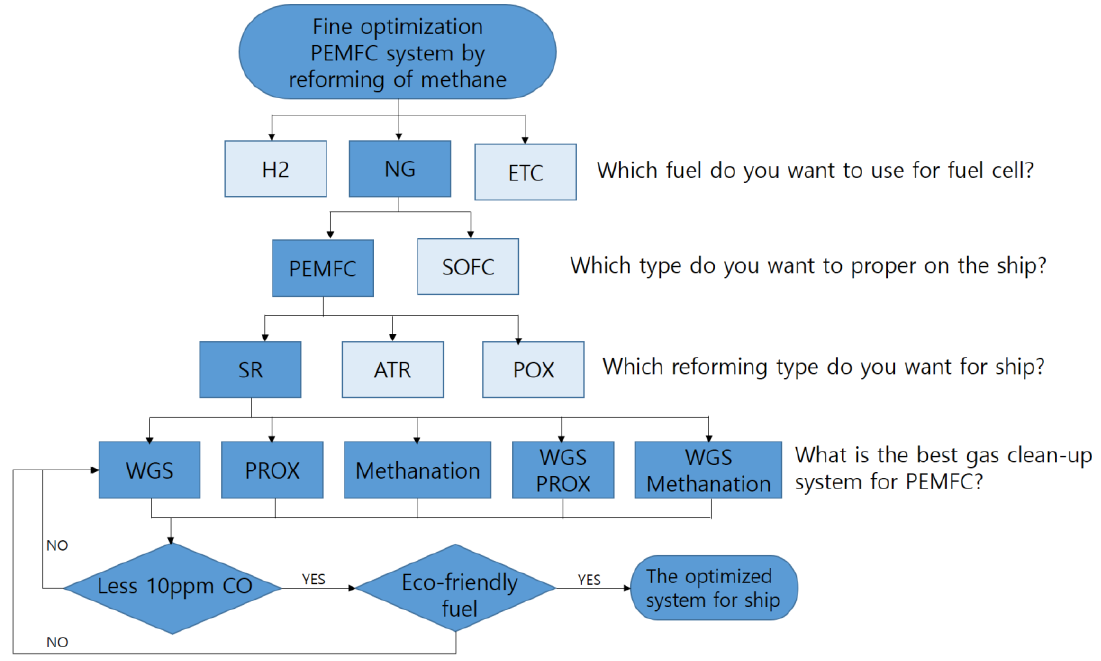
Figure 3. Process of methane reforming PEMFC system.